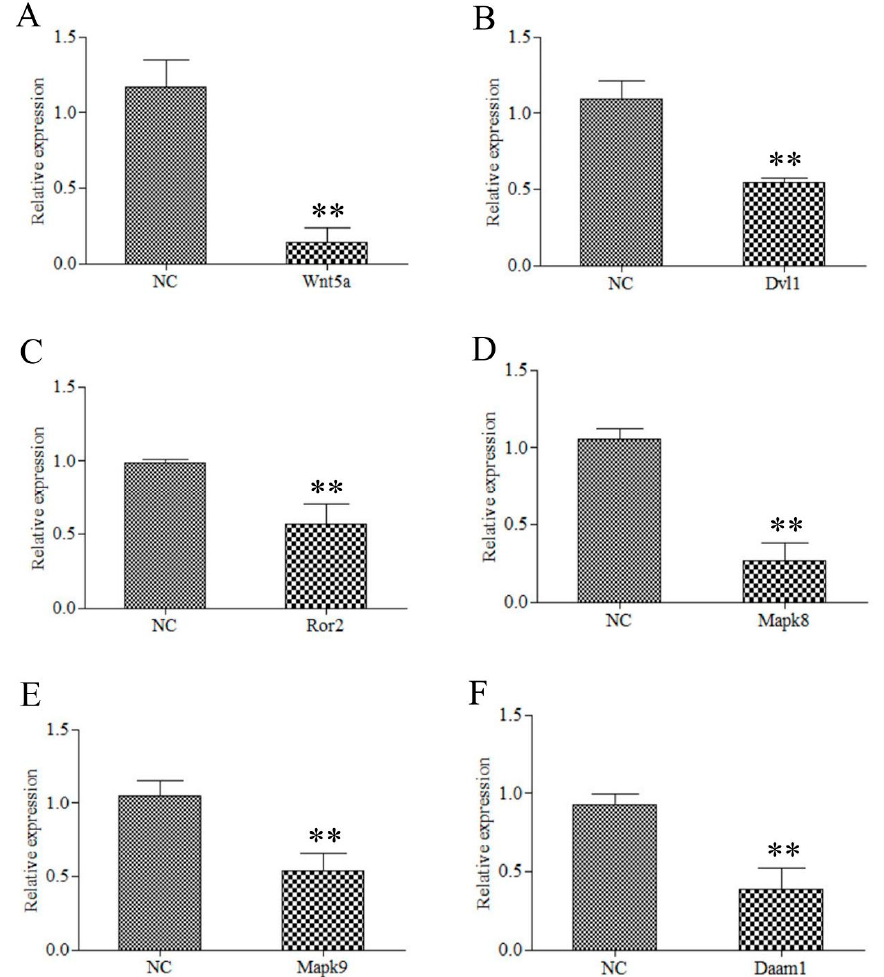
Figure 8. Knockdown of the expression of Wnt5a in CR tissues cultured in vitro. ( A ) The expression level of Wnt5a in the 5 ′ Cho-si- Wnt5a group was significantly lower than that in NC group after 48 h of 5 ′ Cho-si- Wnt5a interference. ( B – F ) The expression levels of Dvl1 , Ror2 , Mapk8 , Mapk9 , and Daam1 in the 5 ′ Cho-si- Wnt5a group were significantly lower than those in the NC group after 48 h of 5 ′ Cho-si- Wnt5a interference. ** represents extremely significant difference ( p < 0.01).